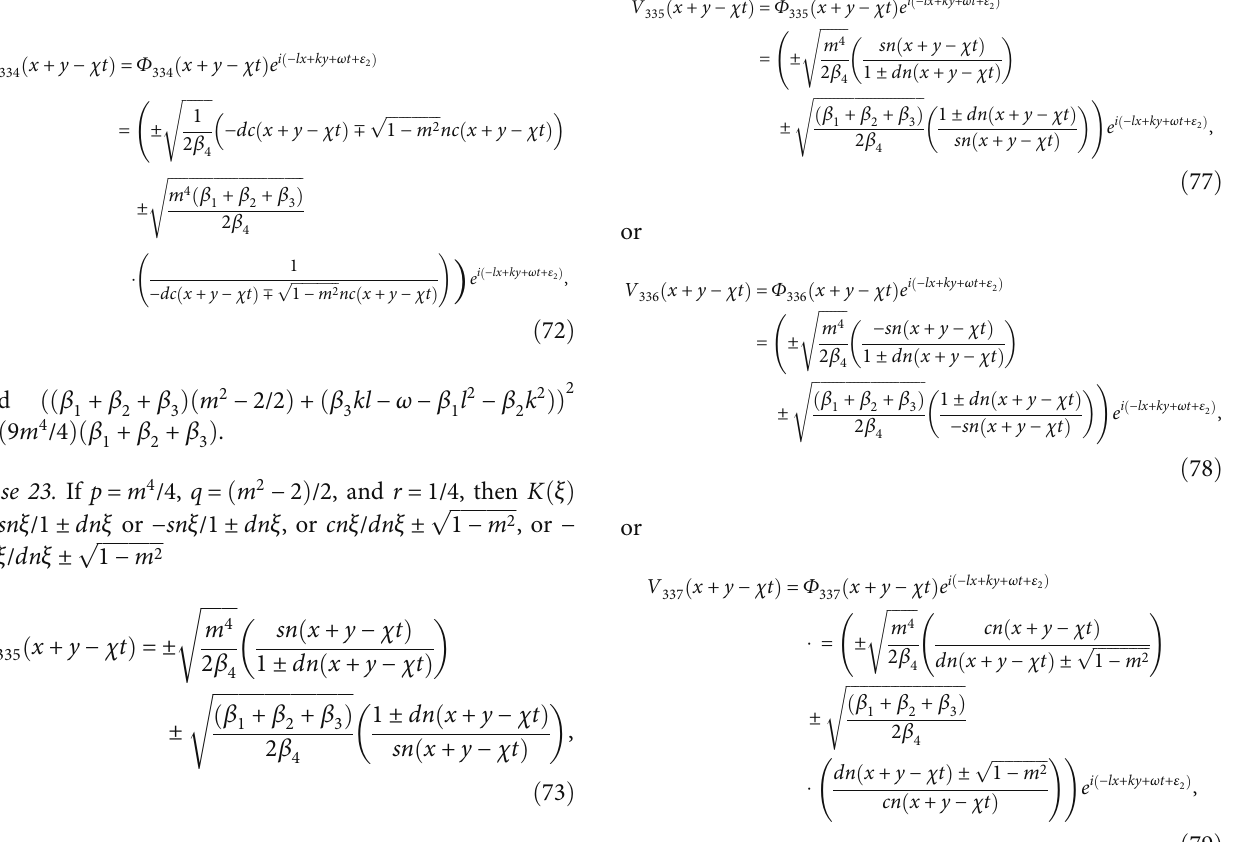
ffiffiffiffiffiffiffiffiffiffiffiffiffiffiffiffiffiffiffiffiffiffiffiffiffiffiffi β + β + β ð 1 2 3 ffiffiffiffiffiffiffiffiffiffiffiffiffi p 1 − m 2 Þ ±